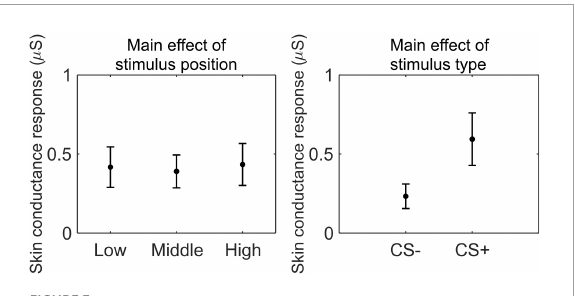
FIGURE3 Skin conductance response during threat learning. Each plot shows the group mean (black dot) and 95% confidence intervals (vertical bars) of the skin conductance response as a function of the stimulus position or the stimulus